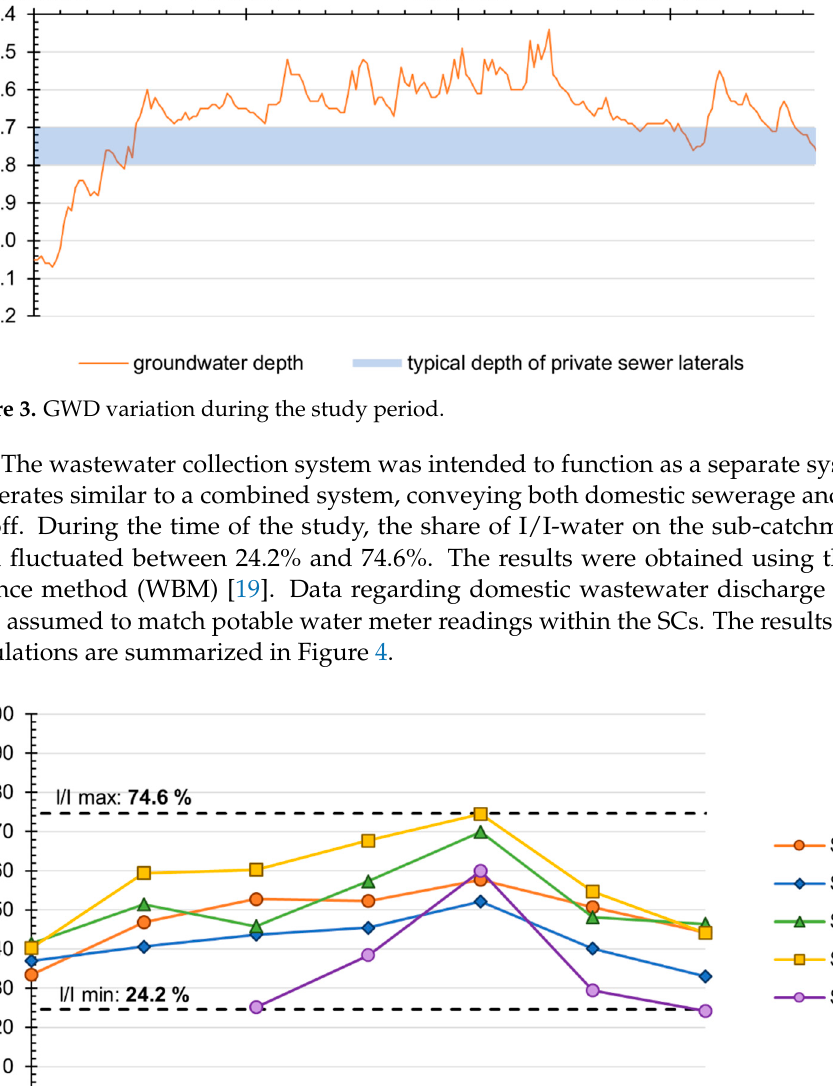
Figure 3. GWD variation during the study period.